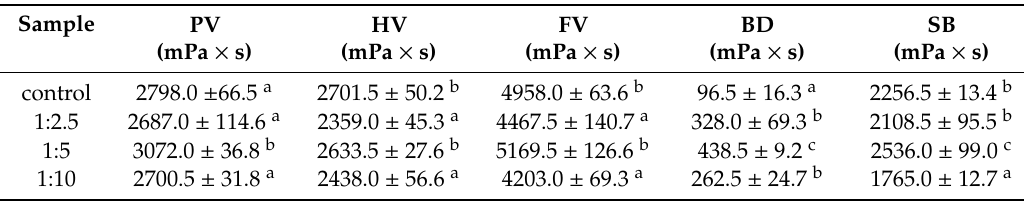
Table 3. Pasting curve